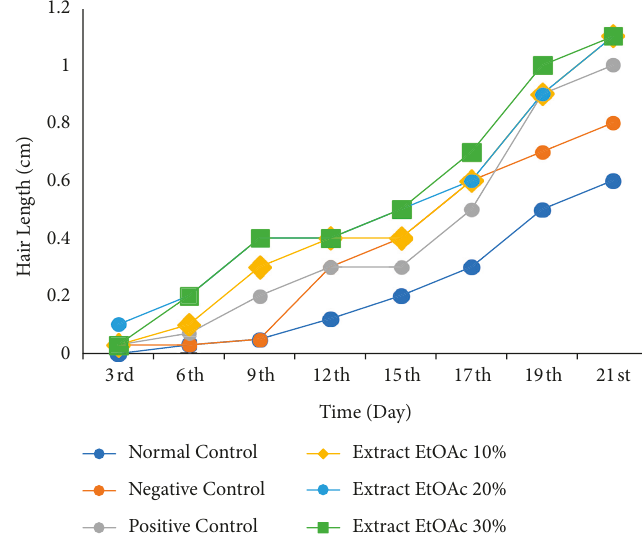
Figure 1: Test of M. peltata leaf ethyl acetate extract on rabbit hair growth.